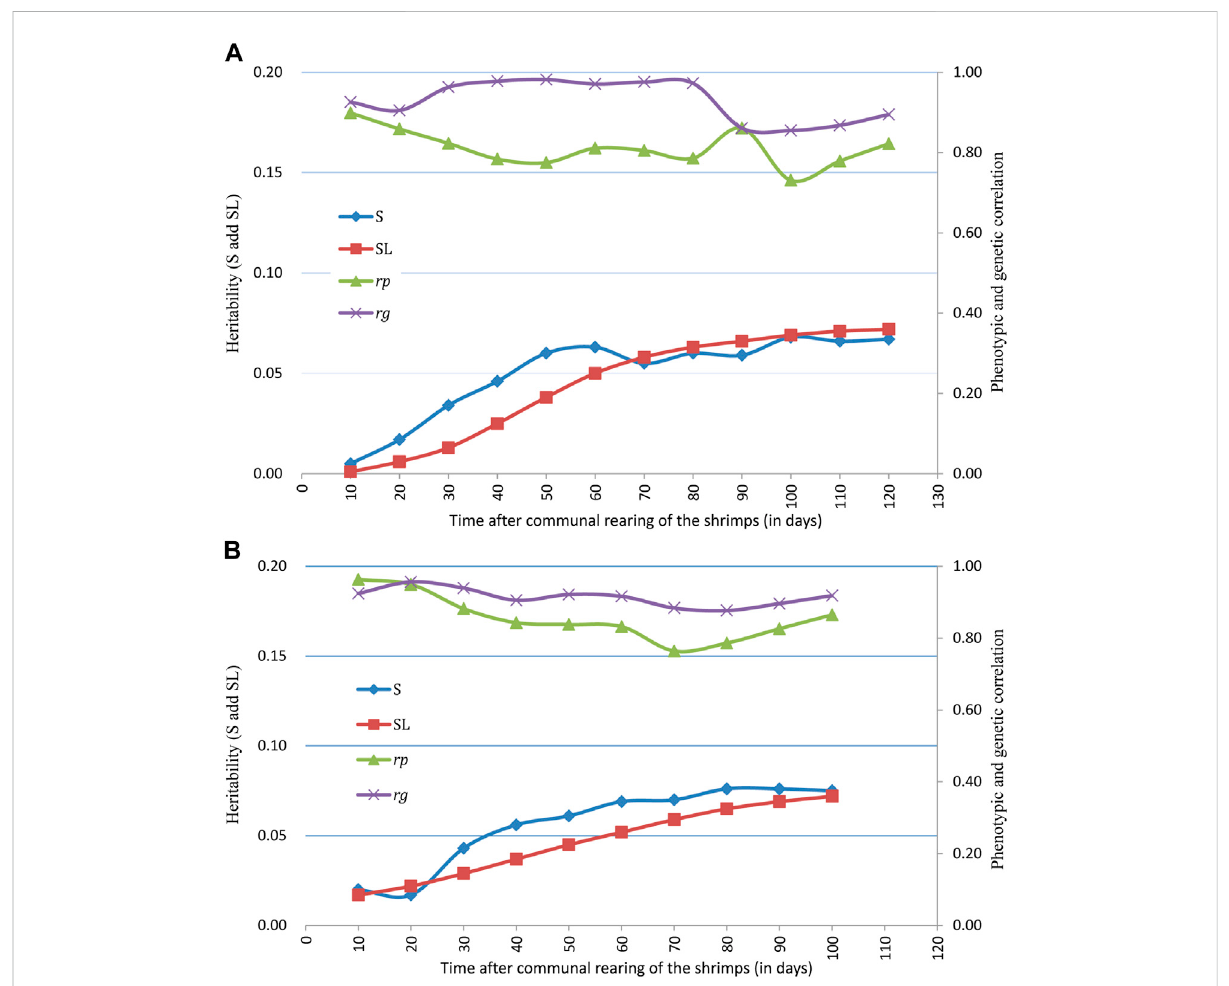
FIGURE 2 Trajectories ofheritabilityfor survival traits(Sand SL), phenotypic correlation ( r p )andgenetic correlation ( r g )betweenSand SLacross grow-out test period of (A) BL2019 line, (B) BL2020